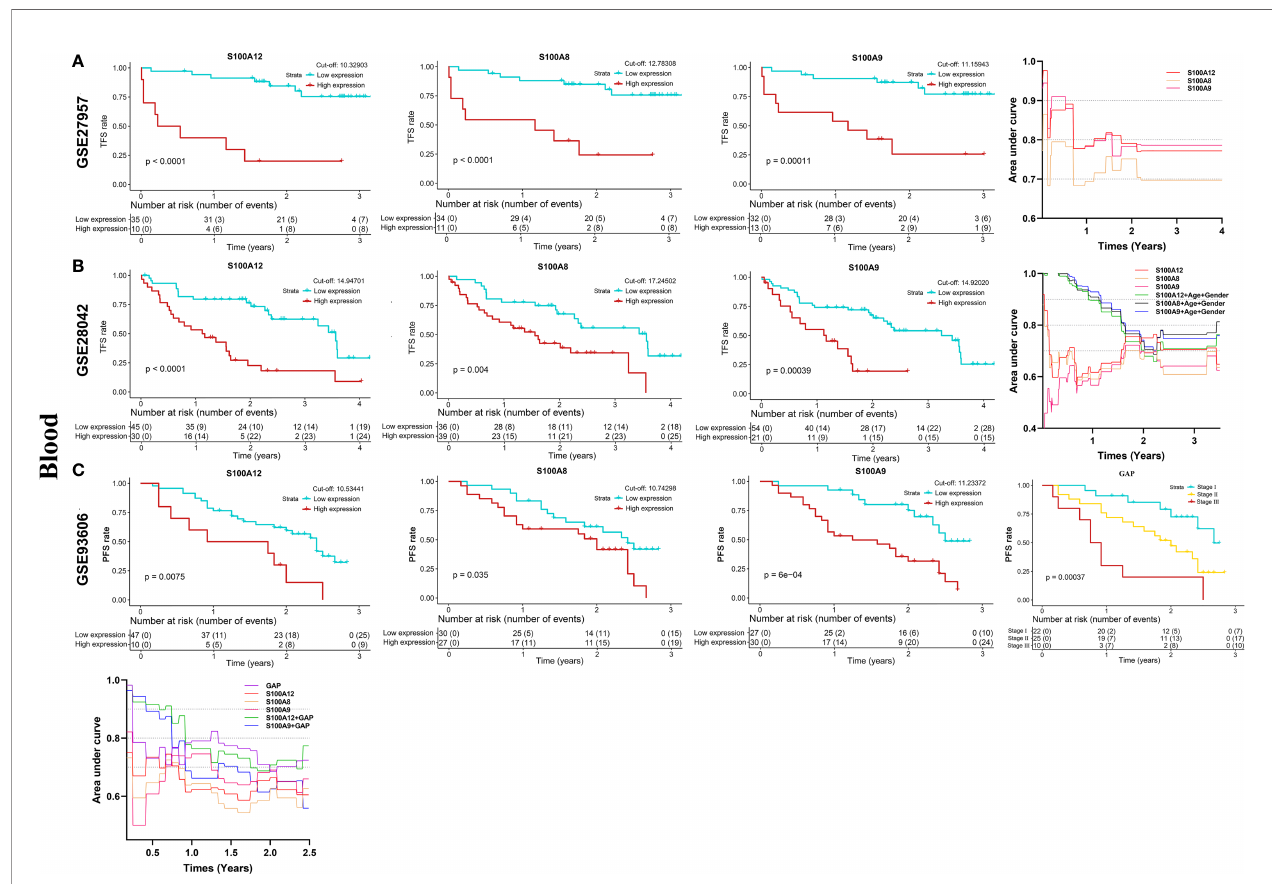
FIGURE 5 | K-M analysis and the predictive value of S100A12, S100A8, S100A9 and GAP index for the TFS and PFS in the blood of patients with IPF. (A) GSE27957 dataset (TFS), (B) GSE28042 dataset (TFS), (C) GSE93606 dataset (PFS). The acquisition of composite variable such as S100A12 + GAP was based on the multivariable Cox